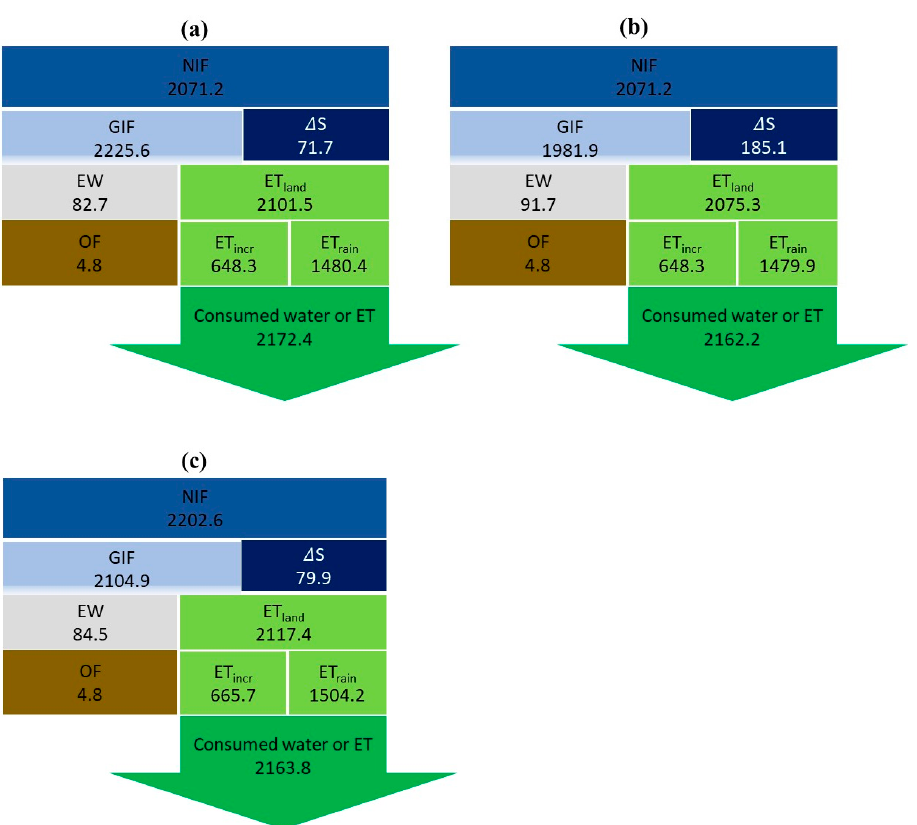
Figure 11. Main water use accounting categories in the NRB, ( a ) wet year (2012), ( b ) dry year (2016), and ( c ) annual average flows 2009–2020. The arrow indicates the water consumed in the whole basin. The units are expressed in km 3 .